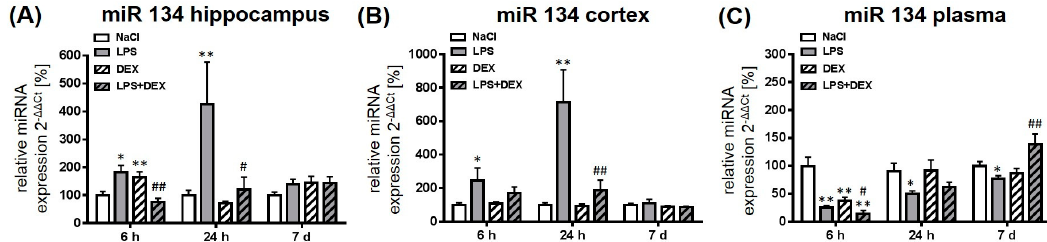
Figure 4. Representation of miR 134 expression after LPS and dexmedetomidine treatment in the hippocampus ( A ), cortex ( B ), and plasma ( C ). Results are shown as mean ± SEM ( n = 6–8 per group). Data are normalized to levels of saline-treated rats (control = 100%). * p < 0.05 and ** p < 0.01 represent the difference compared to saline-treated groups. # p < 0.05 and ## p < 0.01 represent the difference between LPS and LPS in combination with dexmedetomidine-treated groups.